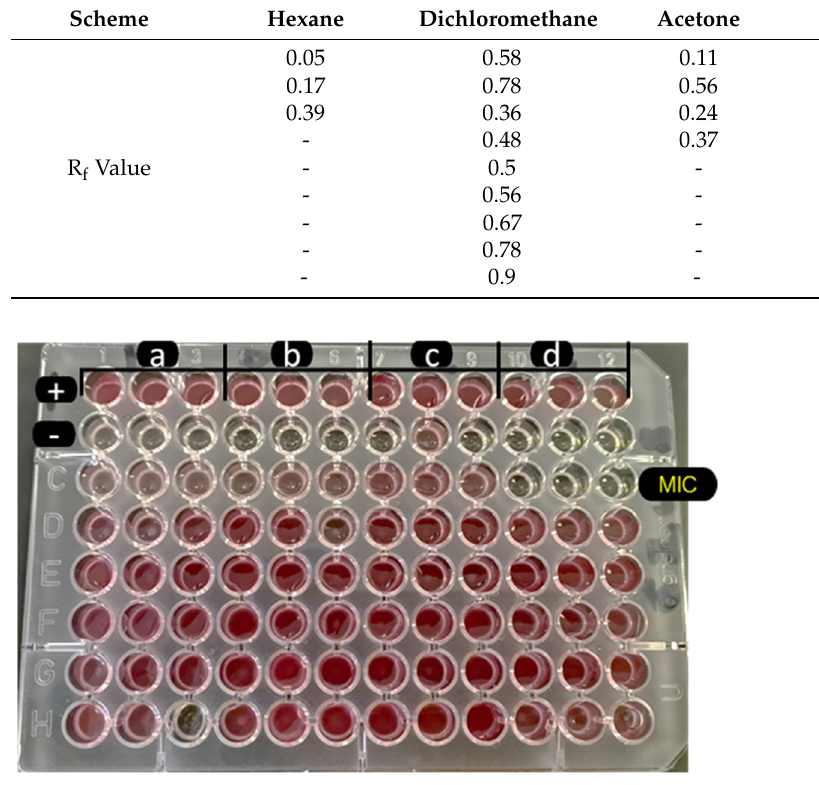
Figure 3. MIC determination of methanol M. balsamina Linn extract that inhibits A. baumannii growth. +: Positive control; -: Negative control; ( a ) hexane extract; ( b ) DCM extract; ( c ) acetone extract; ( d ) methanol extract; MIC: Determined MIC of methanol extract. Each experiment was carried out in triplicate.